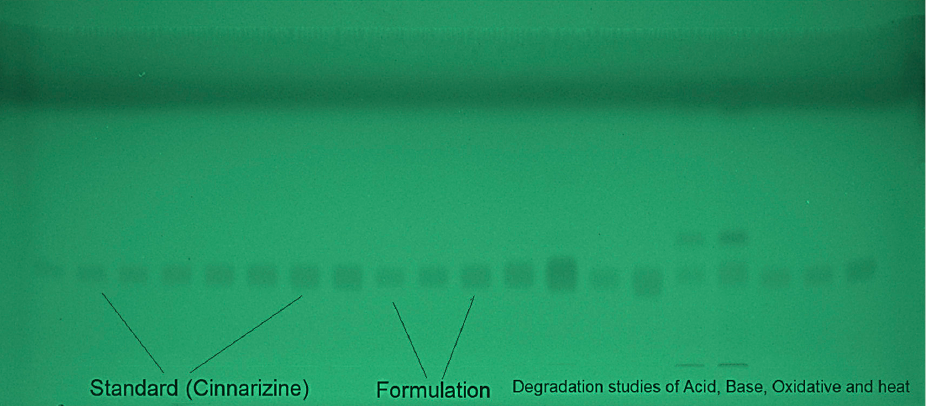
Figure 2. A typical, thin-layer chromatography (TLC) chromoplate of the standard CIN, formulations, and forced degradation samples derived from an eco-friendly EtOH-H 2 O (90:10 v / v ) mobile phase for the current